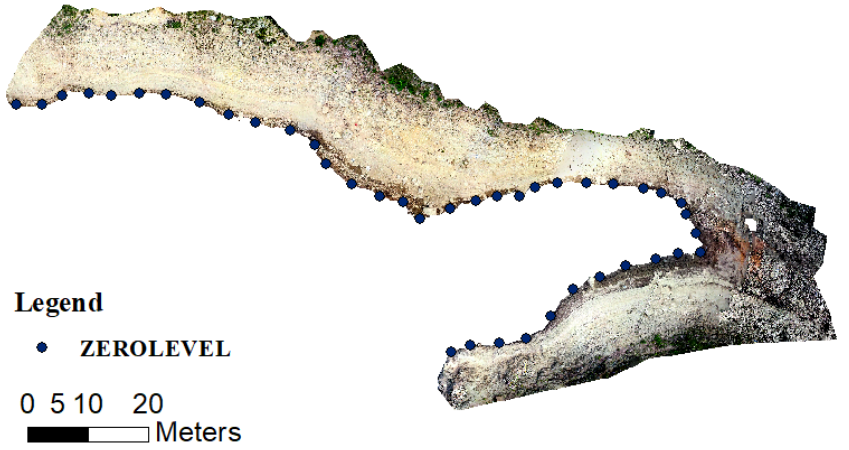
Figure 7. Orthophoto obtained from digital photogrammetric images elaboration. The black dots represent the points along the shoreline, i.e., zero-level.